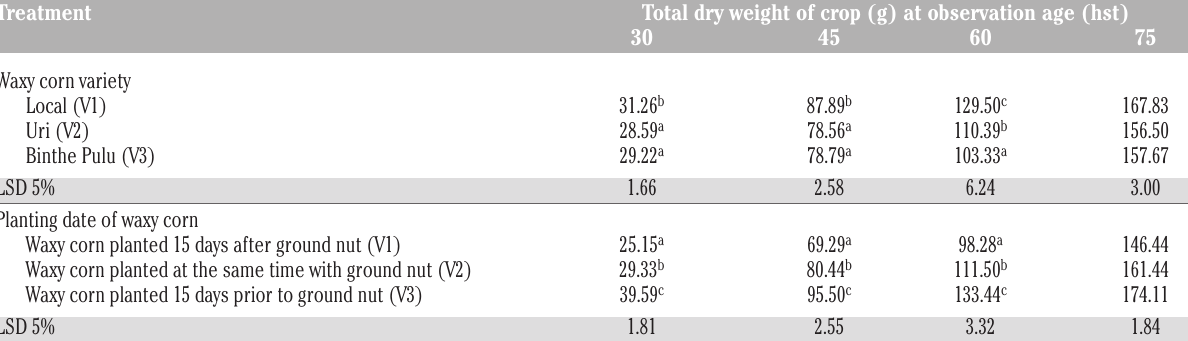
Table 2. Average total dry weight of waxy corn crop in 3 varieties and 3 planting dates at 4 observational ages.